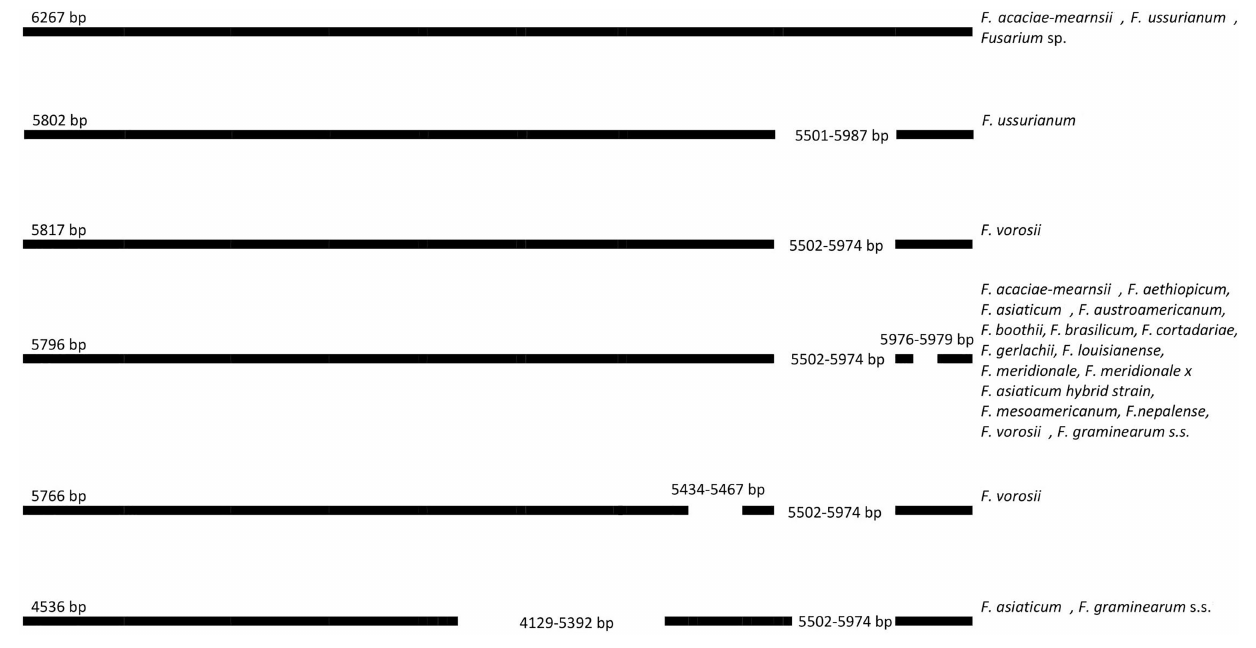
FIGURE 1 | Schematic position of indels in LV-uORF in 122 Fusarium